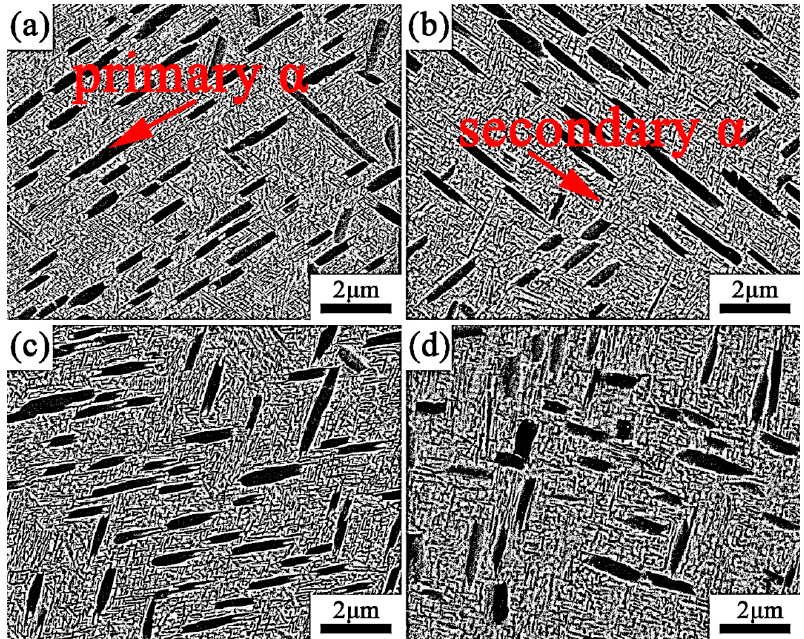
Figure 9. Microstructures of the alloy after solution treatment at 780 °C for 1 h and aging at 540 °C for